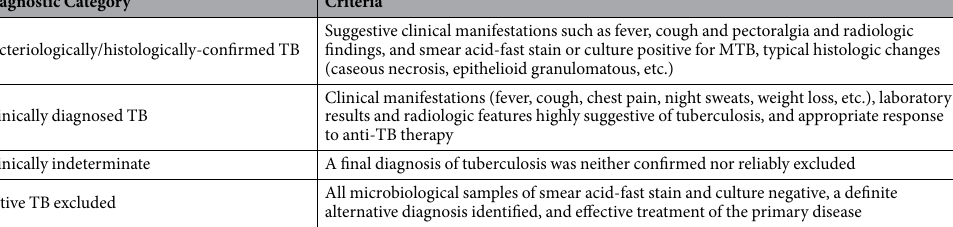
Table 1. Categorization of the Study Population.